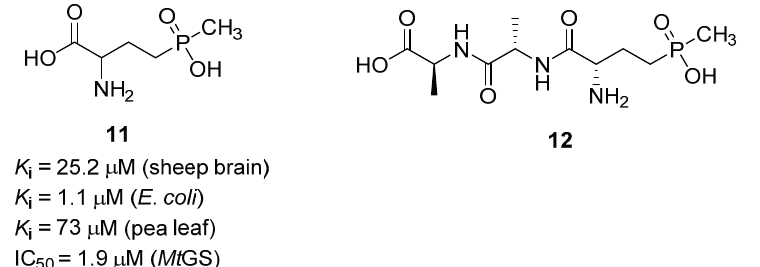
Figure 4. Structure and biological activity of phosphinothricin ( 11 ), and structure of its tripeptide precursor ( 12 ). References: sheep brain [37], E. coli [26], pea leaf [25] and Mt GS [28].